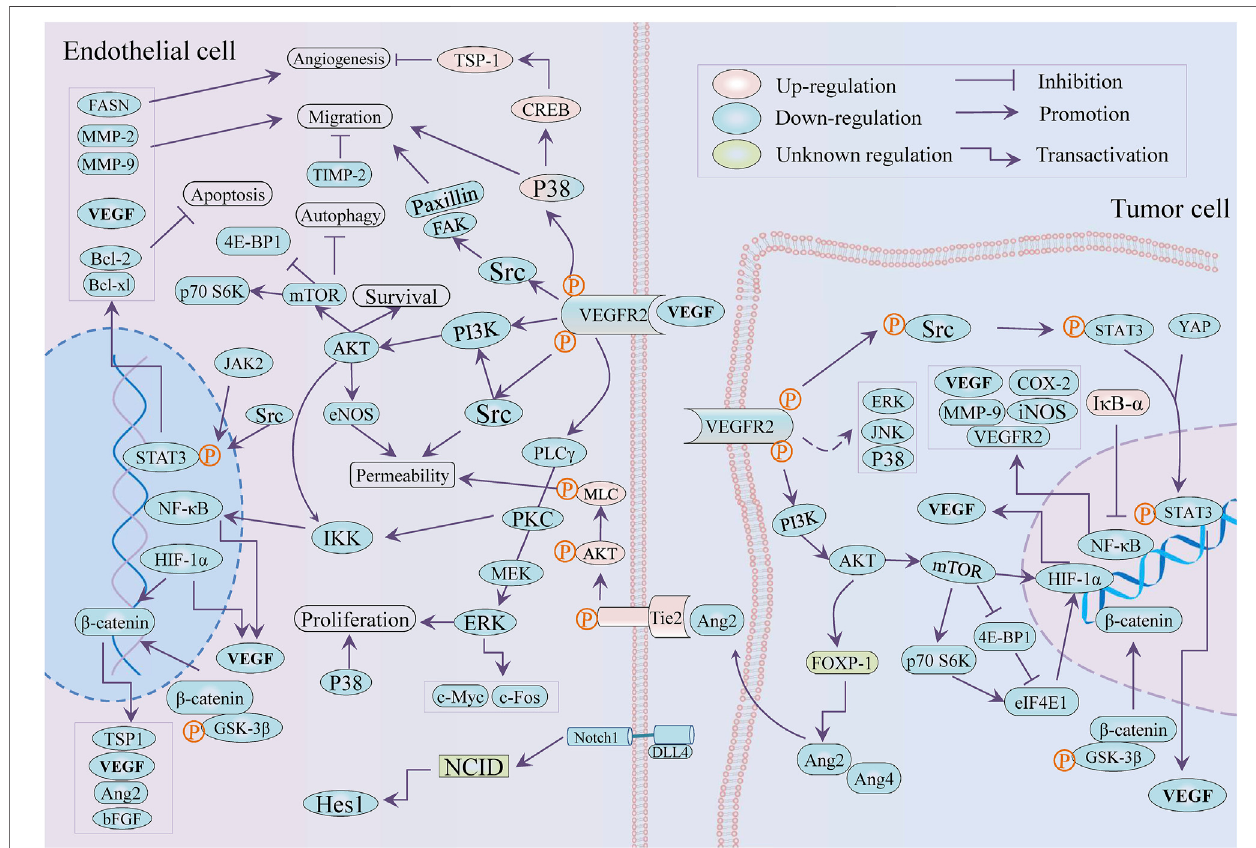
FIGURE 3 | Schematic role of ethnopharmacology in tumor angiogenesis.